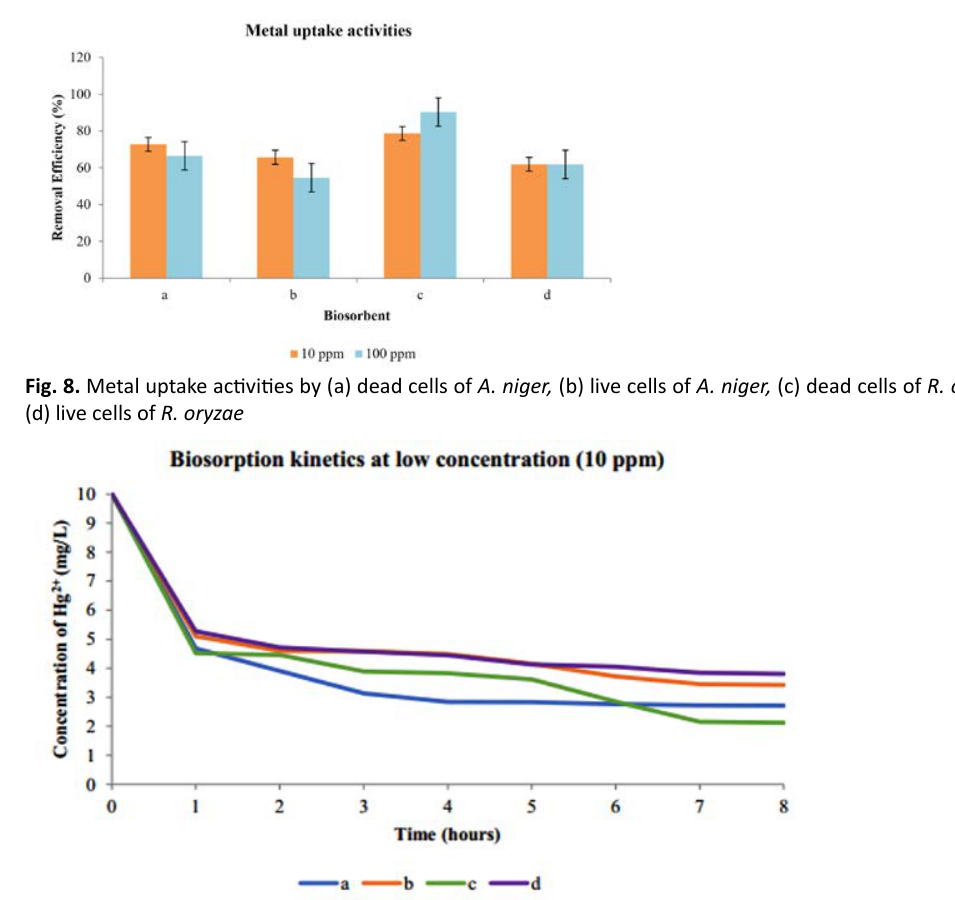
Fig. 9 . Kinetics of biosorption of Hg 2+ at low concentration (10 ppm) by (a) dead cells of A. niger , (b) live cells of A. niger , (c) dead cells of R. oryzae and (d) live cells of R.